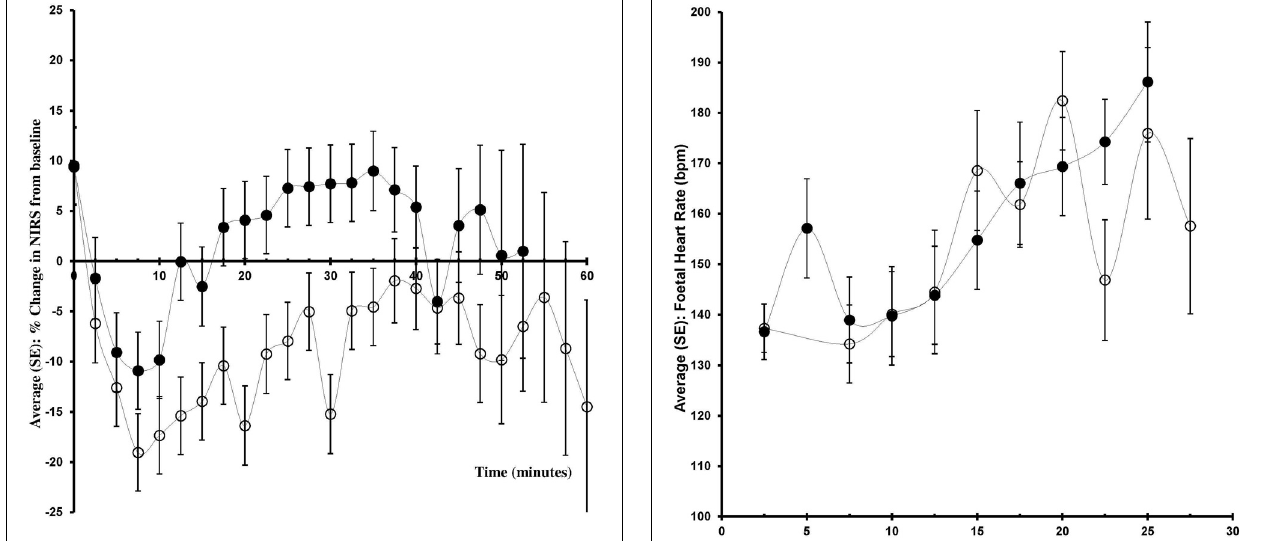
FIGURE 2 | Change in ScO 2 from baseline. Changes in frontal lobe oxygenation (ScO2; % from baseline) during caesarean section with spinal anesthesia. Patients received either phenylephrine ( n = 12; open circles) or ephedrine ( n = 12; black circles).